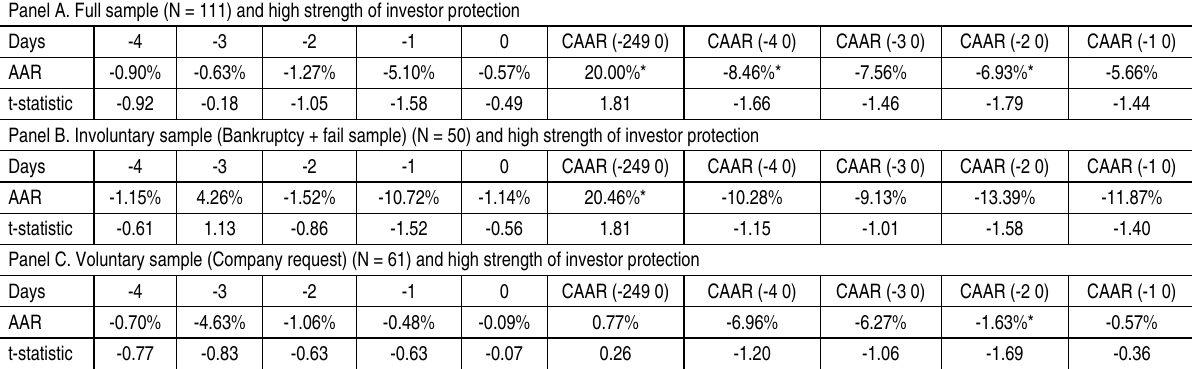
Table 6. Average abnormal returns and cumulative average abnormal returns around delistings announcement days, based on the strength of investor